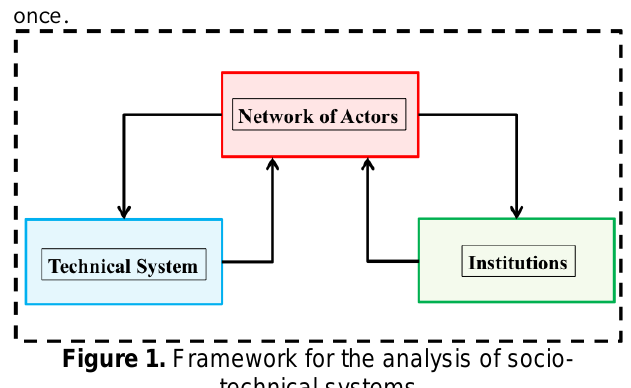
Figure 1. Framework for the analysis of socio- technical